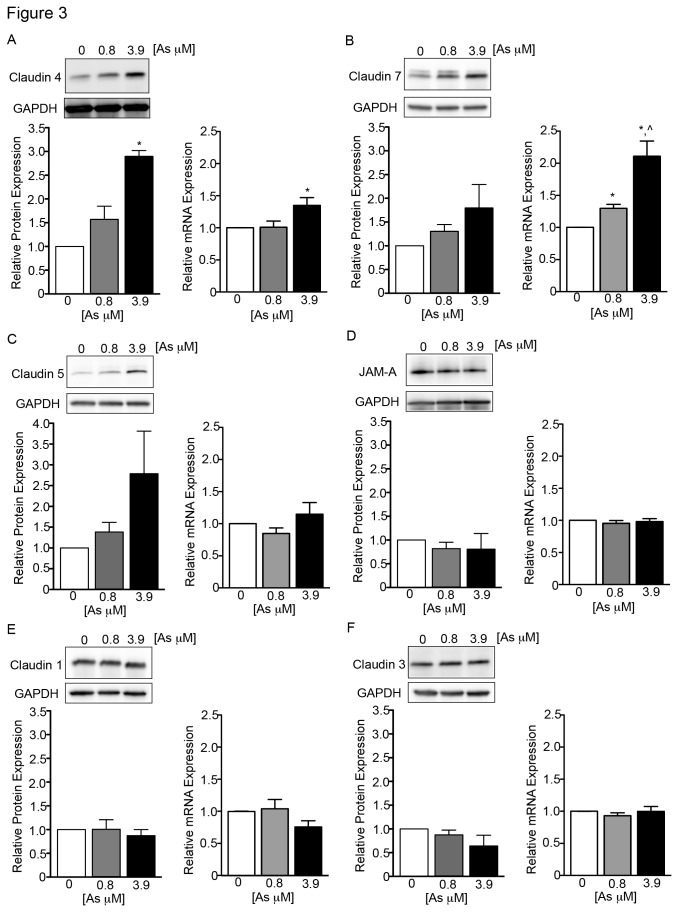
Arsenic exposure alters the molecular expression of tight junction proteins in human airway epithelial cells.Protein and mRNA levels were quantified for conducting airway tight junction proteins in 16HBE14o- cells following a 5-day arsenic exposure. Cl-4 (A) protein was significantly increased at the 3.9 μM As concentration (representative Western blot and densitometry at left) and mRNA was significantly increased at the 3.9 μM As concentration (at right). Cl-7 (B) showed visible increases in protein expression under arsenic exposure that did not reach statistical significance, however Cl-7 mRNA was significantly increased in a dose-dependent manner. Cl-5 (C) showed increased protein expression under arsenic exposure that did not reach significance and no changes in mRNA levels. JAM-A, Cl-1 and Cl-3 showed no apparent changes in protein or mRNA. (n = 3 for all experiments). “*” indicates significant difference from arsenic-free cultures, “^” indicates significant difference from 0.8 μM arsenic-treated cultures (P < 0.05).